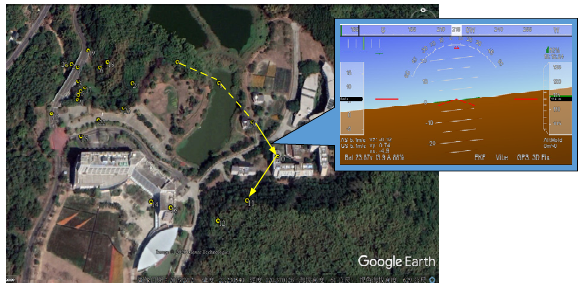
Figure 18. UTM surveillance data with six degrees of freedom (6DoF).